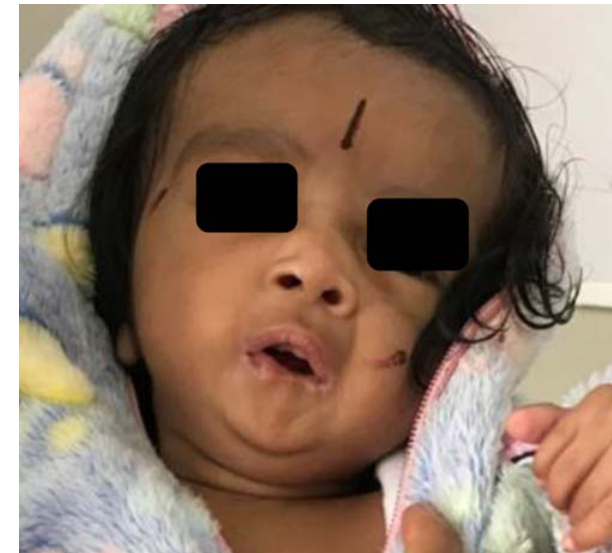
Fig. 4. Immediate post-operative mouth